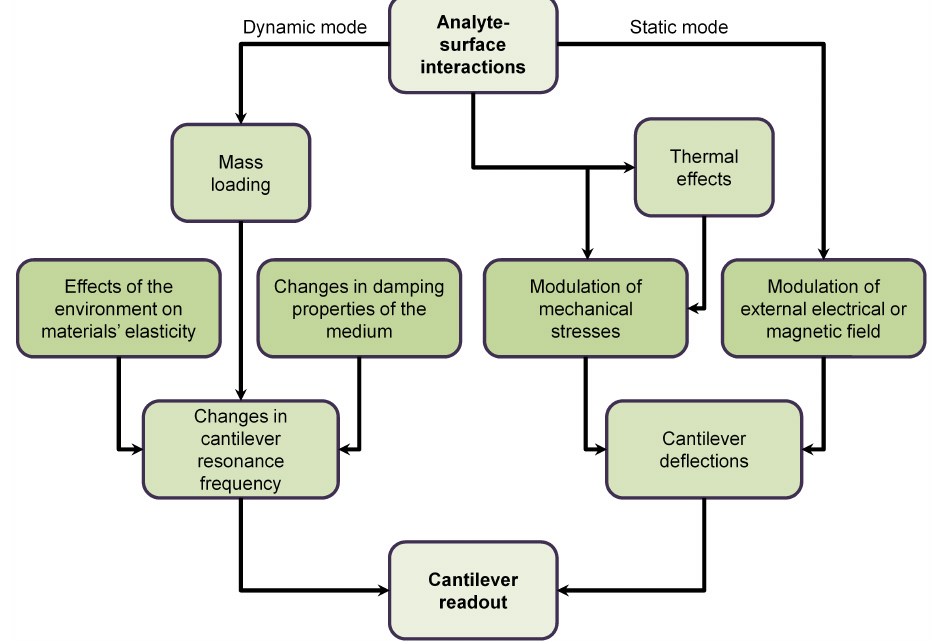
Figure 2. A flowchart describing the modes of operation and the principle of transduction for the microcantilevers. Adapted from the work in